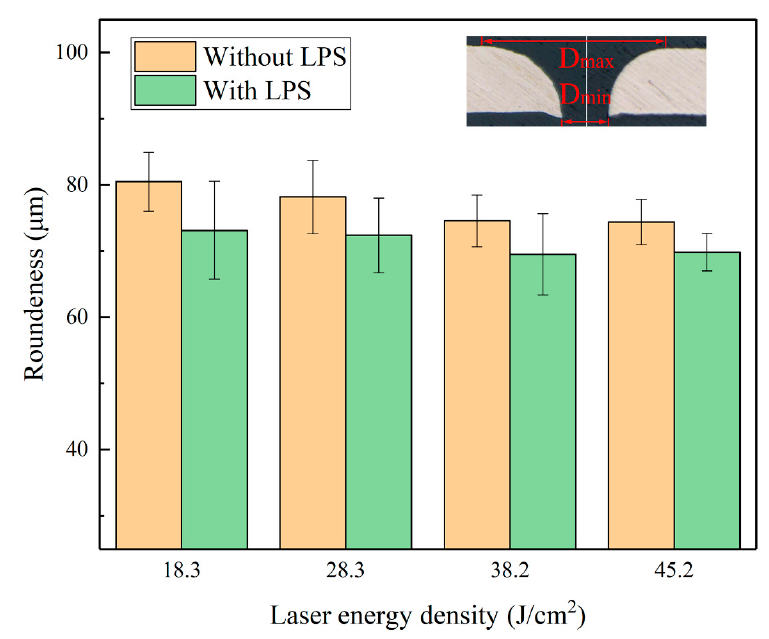
Figure 19. Influence of the laser energy density on the shape accuracy of punched holes with and without LPS.